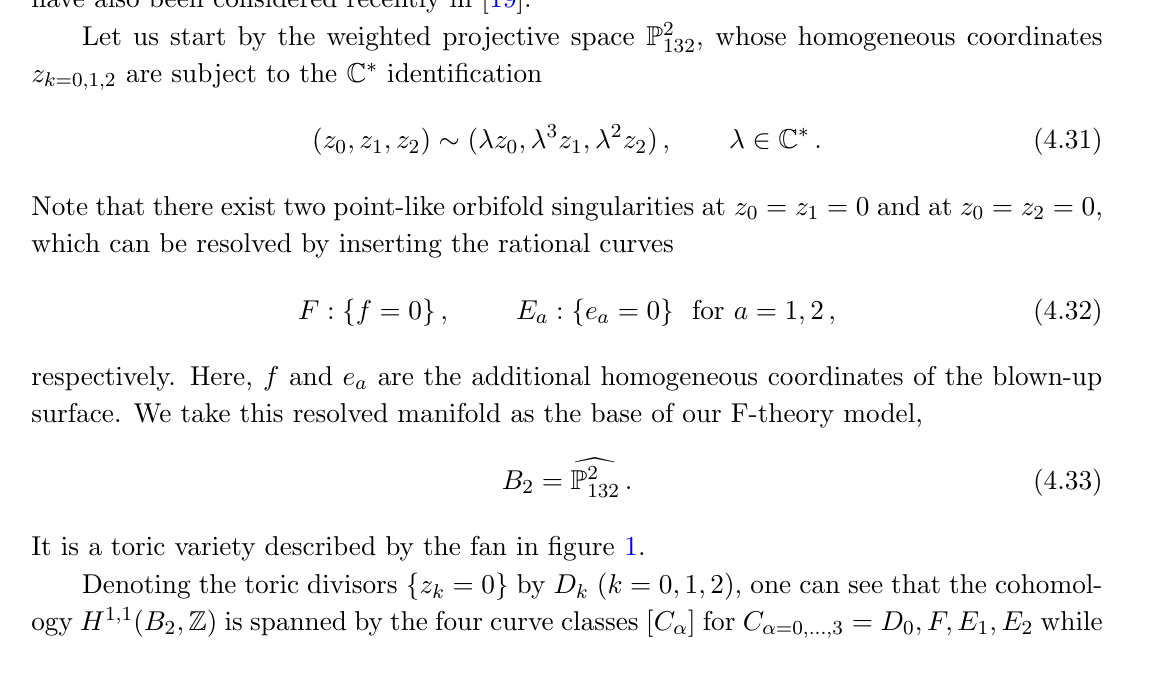
Figure 1 . The two-dimensional fan for the toric surface d P 2 neous coordinate indicated by the